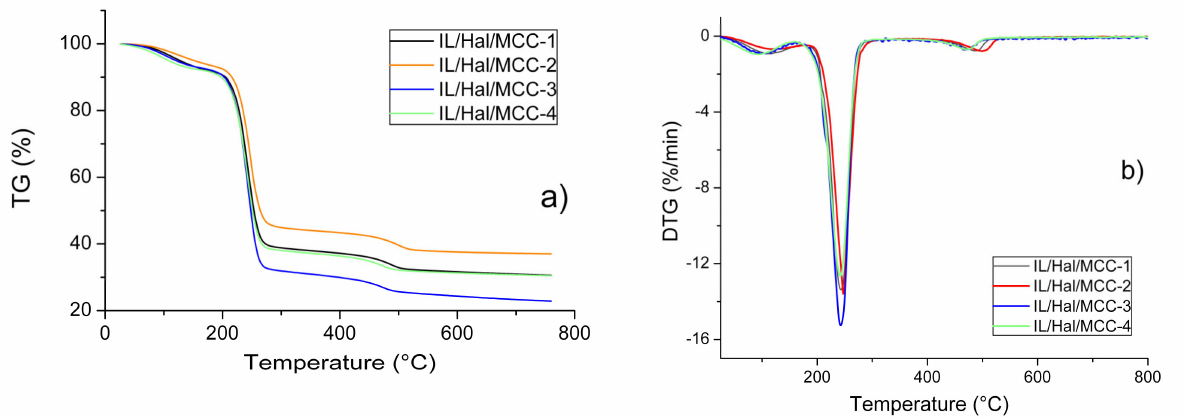
Figure 6. TG ( a ) and DTG ( b ) patterns for IL/Hal/MCC ionogels.